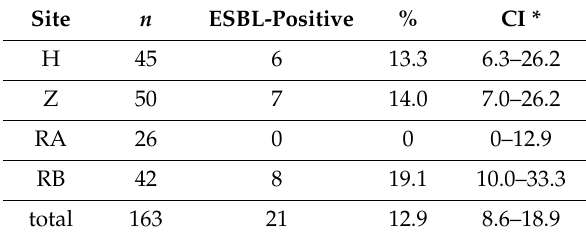
Table 1. Prevalence of ESBL-producing E. coli in 163 flies caught in Berlin,